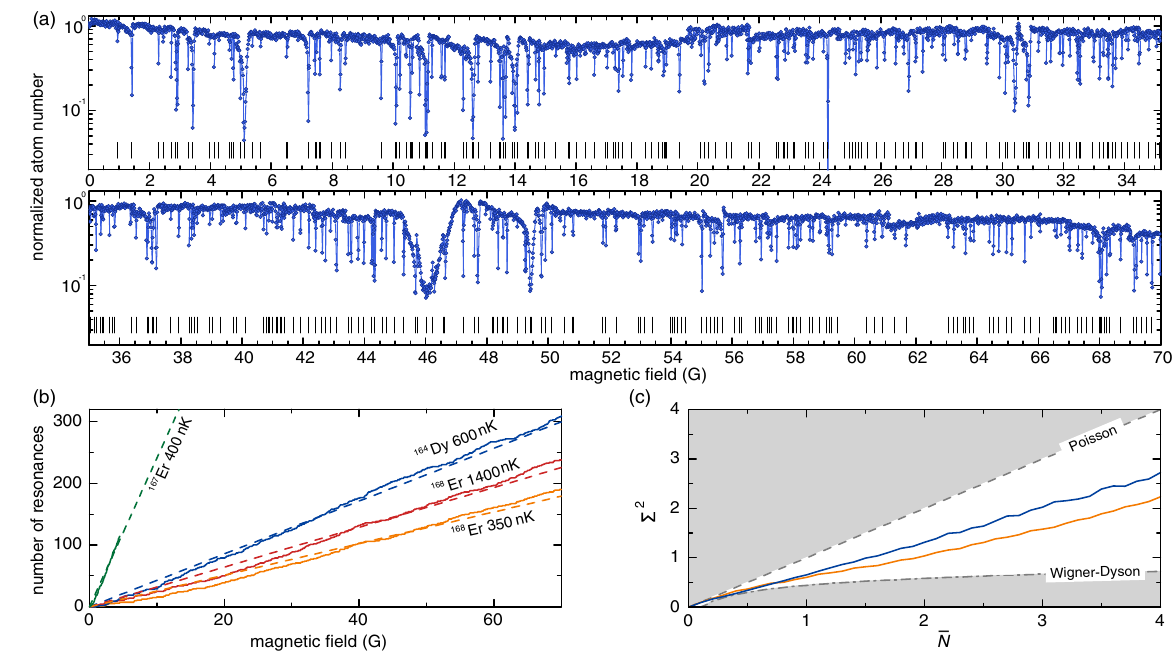
FIG. 1. (a) Trap-loss spectroscopy mapping of the Fano-Feshbach spectrum of 164 Dy as a function of magnetic field between B ¼ 0 and 70 G with a data point every 14.5 mG and temperature T ¼ 600 nK. Each data point is an average of three measurements. (b) Staircase function for the number of resonances as a function of B for 164 Dy, 168 Er at two temperatures, and fermionic 167 Er. Dashed lines are linear fits forced to pass through the origin. Their slopes give a mean density of resonances of ¯ ρ ¼ 4 . 3 G − 1 for 164 Dy, 2 . 7 G − 1 for 168 Er at T ¼ 350 nK, 3 . 4 G − 1 for Er at T ¼ 1 . 4 μ K, and 25 . 6 G − 1 for 167 Er. (c) Number variance of the experimental data ¯ N as a function of scaled B -field interval ¼ Δ B ¯ ρ . The experimental data for 164 Dy (blue line) and 168 Er at T ¼ 350 nK (orange line) lie between the variances for an uncorrelated Poisson distribution (dashed line) and the correlated Wigner-Dyson distribution (dot-dashed